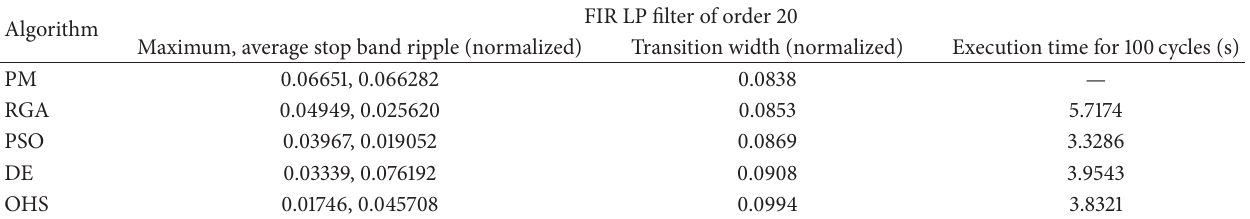
Table 7: Other comparative results of performance parameters of all algorithms for the FIR LP filter of order 20. Algorithm